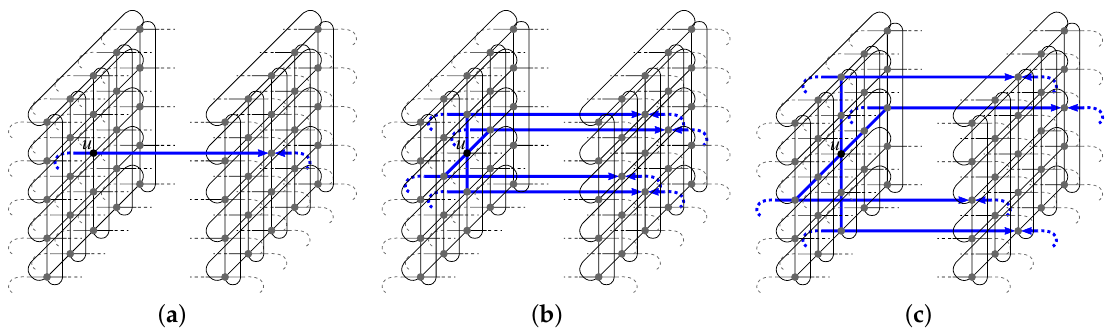
Figure 2. Considered paths (represented by arrows) for traversing the subtori of a (3, 5)-torus from the vertex u . ( a ) p − ( u , δ ) , p + ( u , δ ) , ( b ) P −